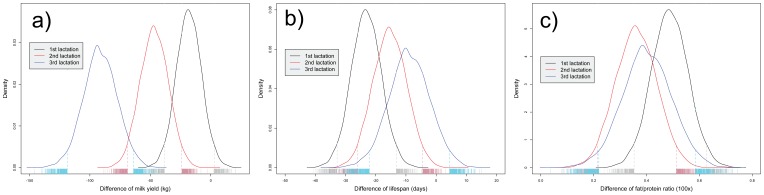
Effect of maternal lactation during embryogenesis on adult performance.The density plots show the posterior distribution of the difference in a) milk yield b) lifespan and c) fat/protein between cows whose embryogenesis occurred during the first (black line), second (red line) or third (blue line) maternal lactation and cows whom embryogenesis occurred in the absence of maternal lactation. The contrasts for presence vs absence of lactation showed lower production level, shorter lifespan and higher fat/protein ratio in the adult life of those individuals conceived during maternal lactation, with statistically significant posterior distributions.